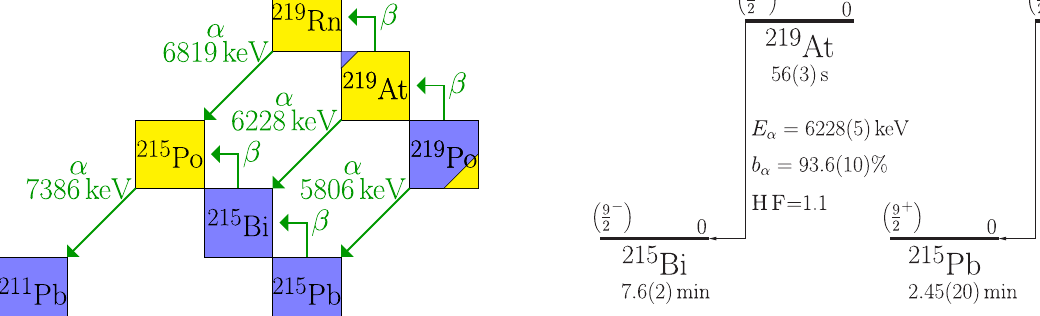
FIG. 15. Decay chain starting from 219 Po down to 211 Pb. α - decaying isotopes are shown in yellow, β -decaying isotopes in blue, and possible decay paths are highlighted with an arrow.